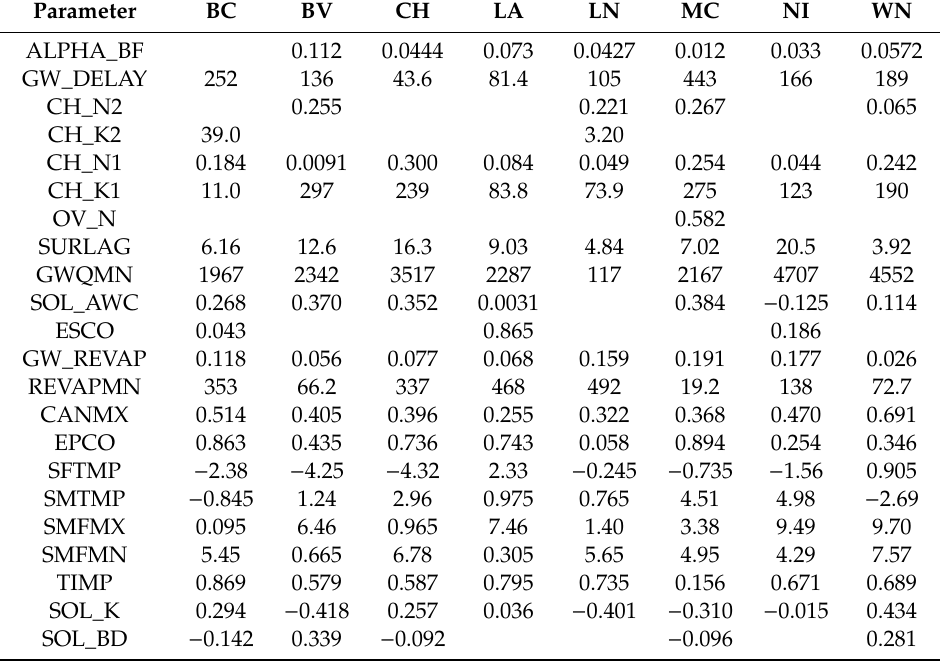
Table 5. Highly sensitive parameters (HSP) from IT_Q simulation.